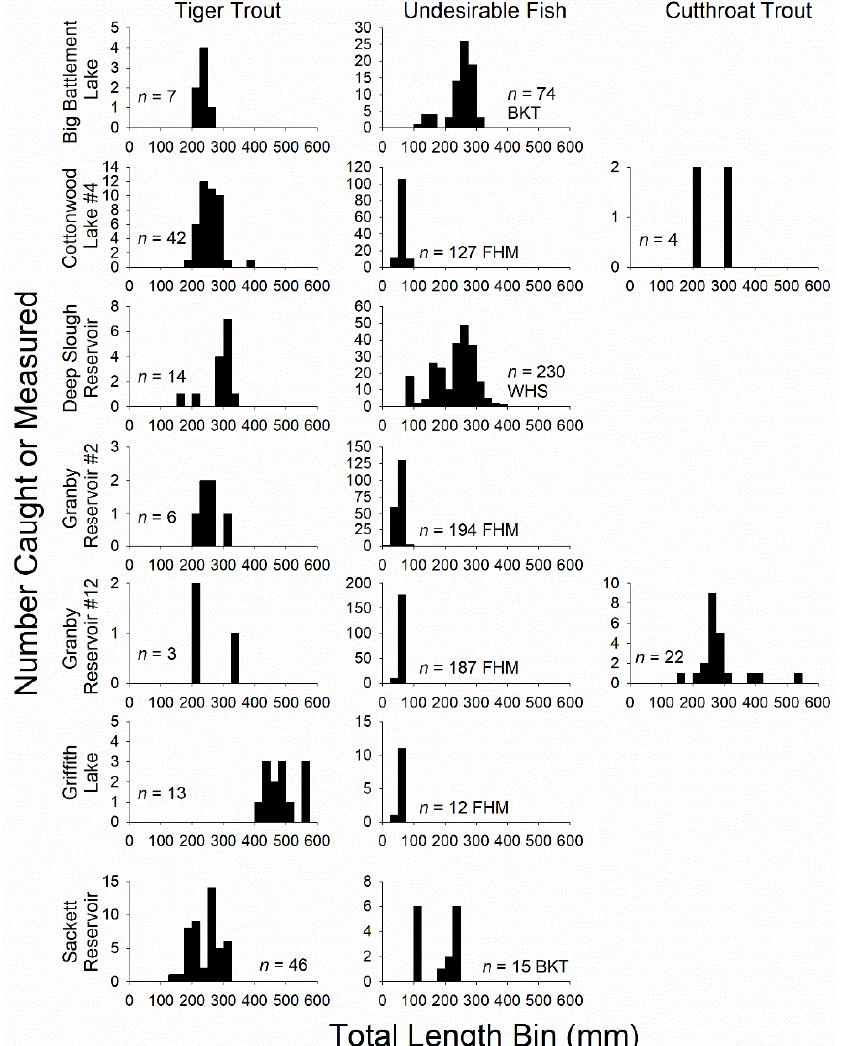
Figure 1. Length-frequency histograms of all fishes including tiger trout, different species of undesirable fish, and cutthroat trout (columns) captured in each study system (rows) during 2017 field sampling. Sample sizes are noted on each panel. The species abbreviation BKT = brook trout, FHM = fathead minnow, and WHS = white sucker. Two large-sized ( ≥ 250 mm TL) rainbow trout were also sampled in Cottonwood Lake #4, but not included in the histogram.